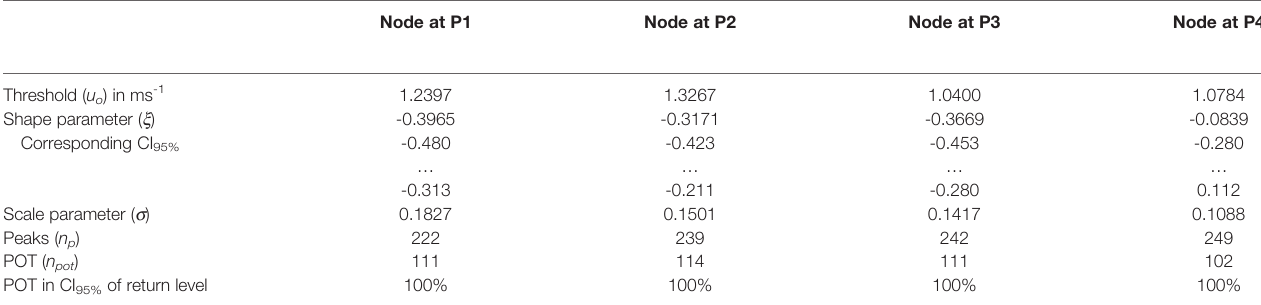
TABLE 1 | Values for GPD fi t for four nodes.